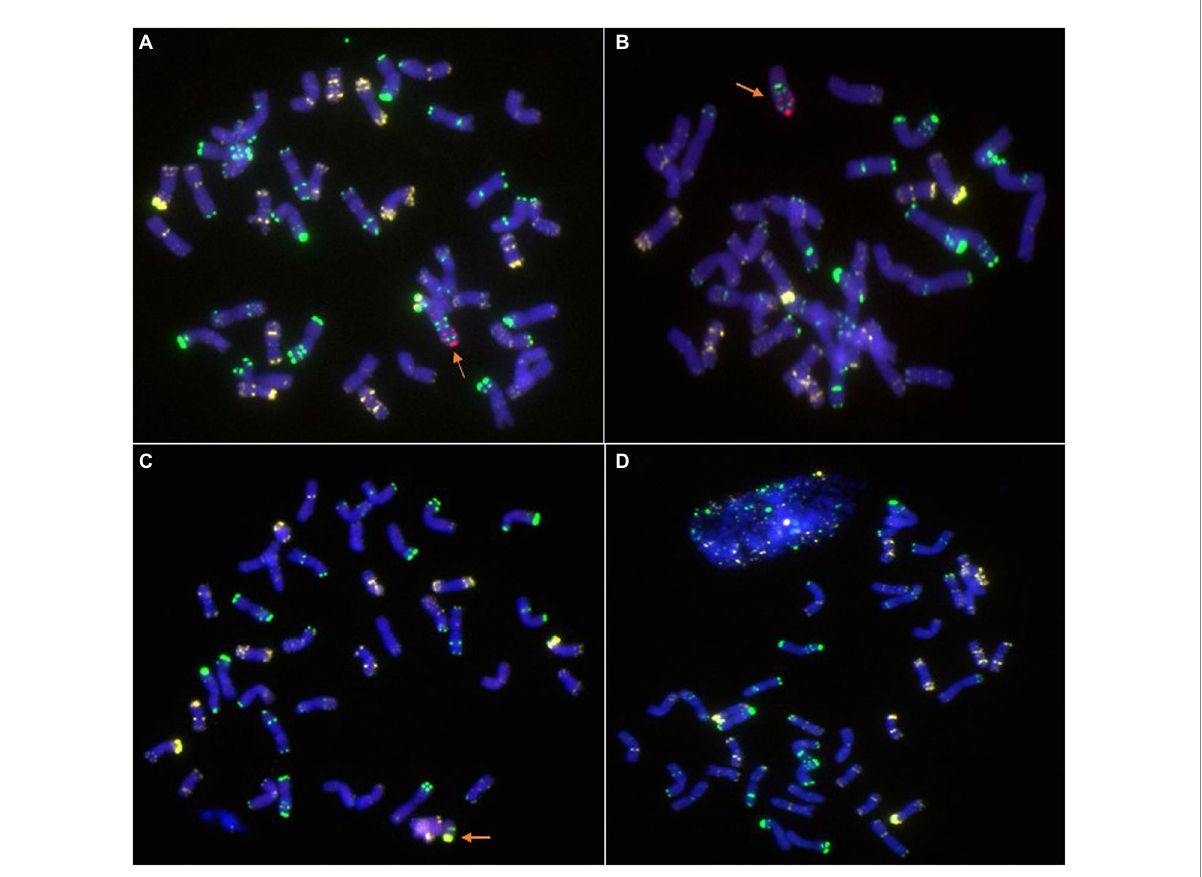
FIGURE 5 Lines with other types identified by ND-FISH. (A) 6R monosomic addition. (B) 6RL monotelosomic addition. (C) 6RS monotelosomic addition. (D) Lines that missed 6R. The arrows show the 6R, 6RL, or 6RS chromosomes. Oligo-pSc119.2-1: green; Oligo-pTa535-1: white; Oligo-Ku, Oligo- pSc200, and Oligo-pSc250: